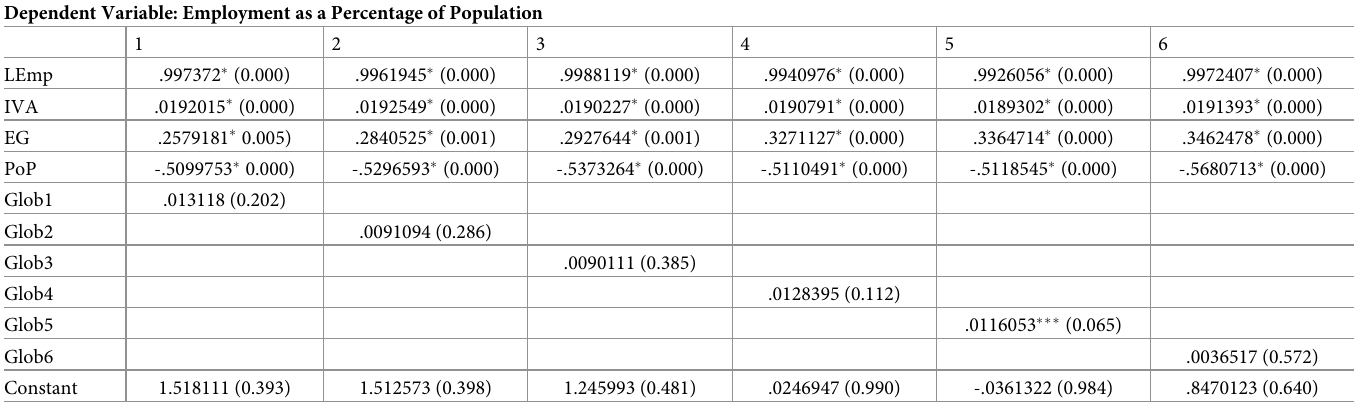
Table 10. Direct impact of globalization on employment (system GMM